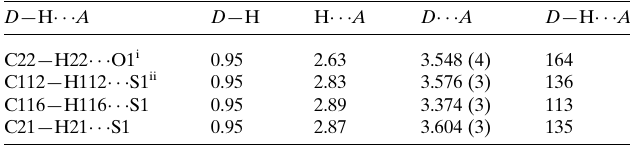
Table 1 Hydrogen-bond geometry (A˚ , (cid:4) ).